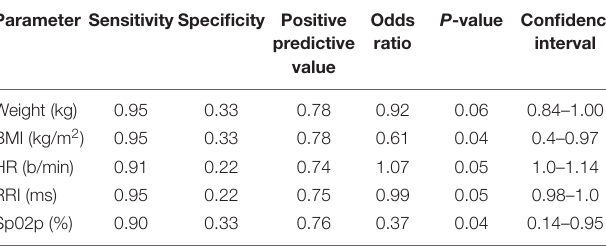
TABLE 3 | Performance diagnostics and odd’s ratio for P0 significant factors.